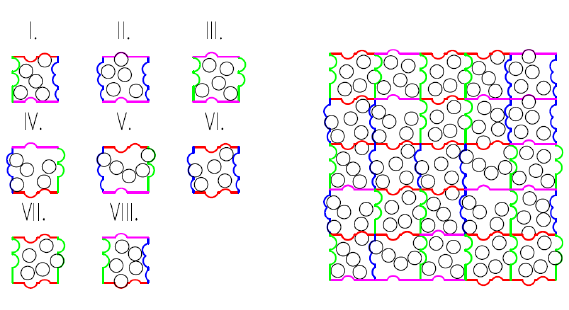
Figure 2. Principle of adaptive